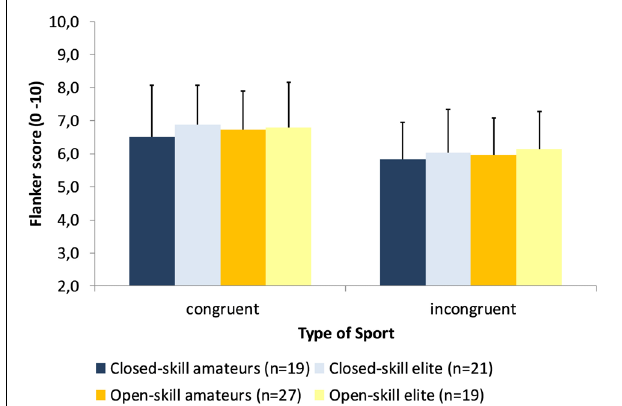
FIGURE 5 | Performance of the Trail-Walking-Test (mean, SD) as a function of expertise and type of sport ( ∗∗ p < 0.01).